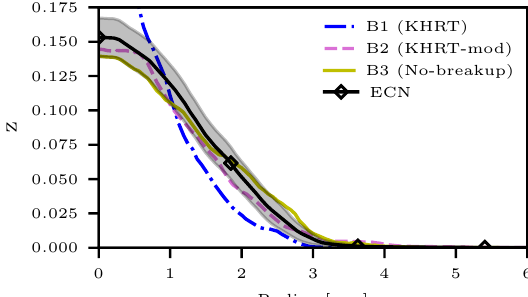
Figure 9. Radial profile of Z at the time 1.5 ms after SOI and axial location 17.8 mm away from the nozzle, considering cases B1–B3 in Table 3. Data points are interpolated and circumferentially averaged for the considered axial location. Solid black lines and filled regions denote the ECN experimental counterparts of Z and its uncertainty, respectively.